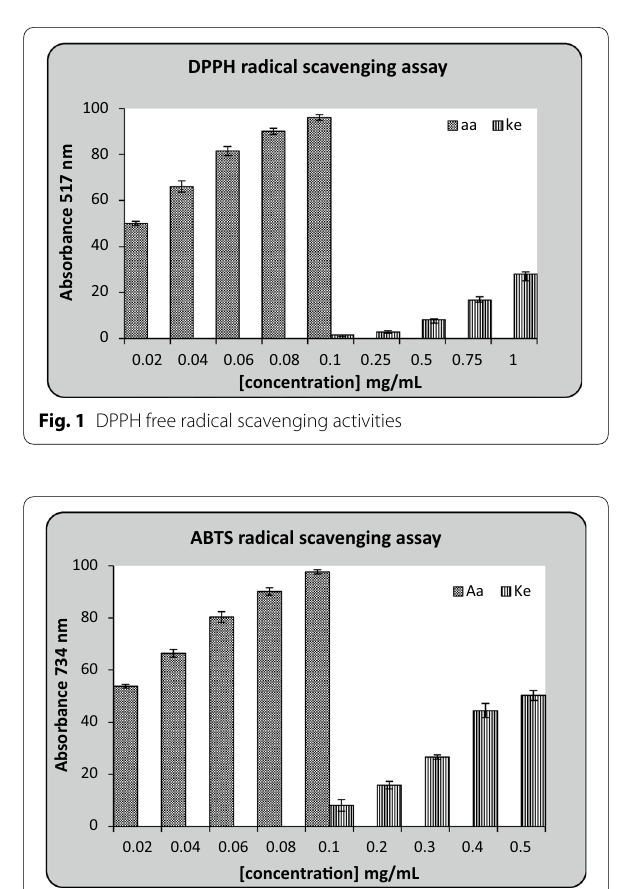
Fig. 2 ABTS free radical scavenging